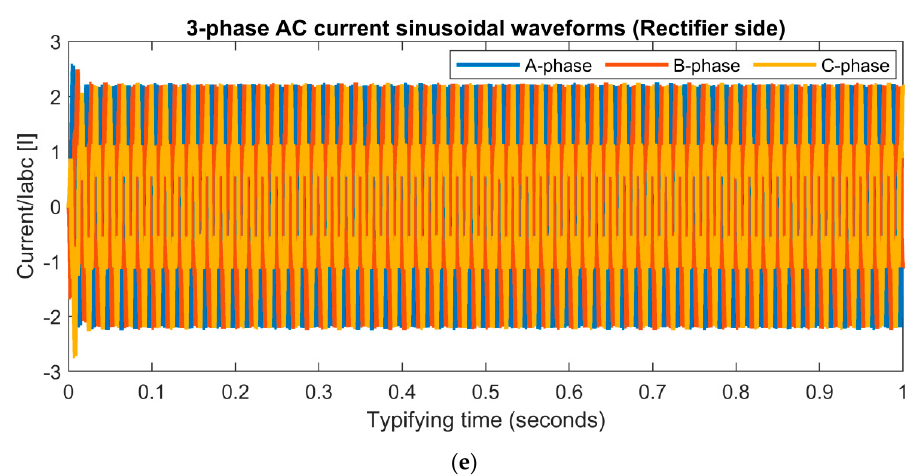
Figure 7. Simulation findings for the HVDC system were achieved during a single phase-to-ground (LG) fault. ( a ) Three-phase AC voltages at the inverter side. ( b ) Three-phase AC currents at the inverter side. ( c ) DC line voltage. ( d ) Three-phase AC voltages at the rectifier side. ( e ) Three-phase AC currents at the rectifier side.